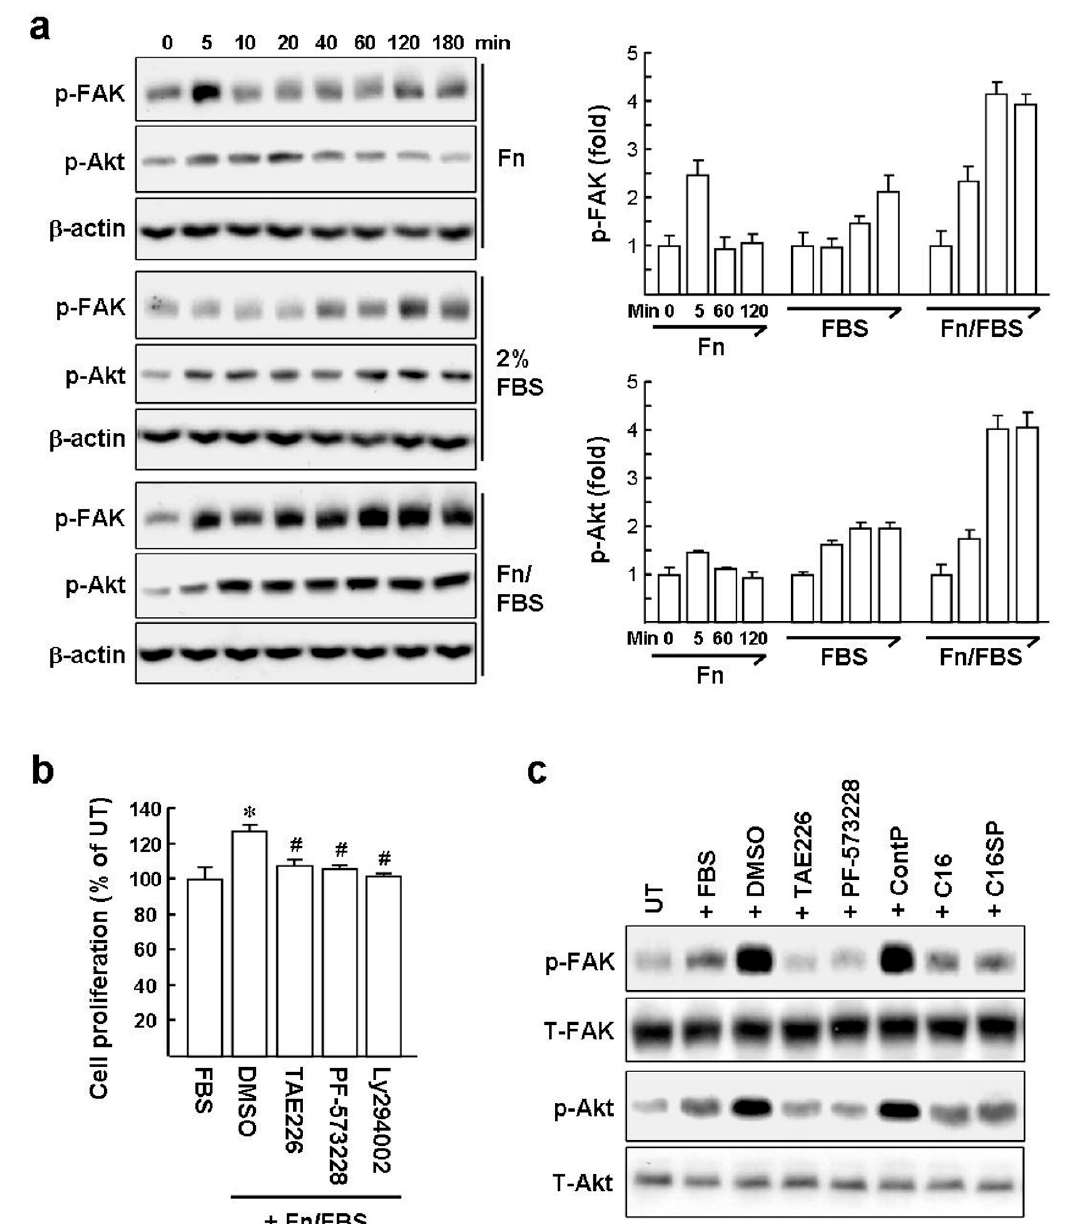
Figure 2. C16 and C16SP suppress Fn and serum-induced HaCat cell proliferation by blocking the FAK / PI3K / Akt signaling. ( a ) Fn and FBS synergistically induce phosphorylation of FAK at Y397 and Akt at T308 in HaCat cells in a time-dependent fashion. Cells were serum starved for 24 h and then treated with fresh medium containing 5 µ g / mL of Fn or 2% FBS or both (Fn / FBS), for the time periods indicated. Representative immunoblots and densitometric analysis are from three independent experiments. β -actin served as a protein loading control. ( b ) E ff ect of the FAK inhibitors (NVP-TAE226 and PF-573228) and PI3K inhibitor (LY294002) on HaCat cell proliferation. Cells were serum starved for 24 h and then exposed to fresh medium containing 5 µ M FAK or PI3K inhibitor for 30 min before addition of Fn / FBS for another 24 h. Cells treated with 2% FBS alone served as proliferative index 100%. Data represent three independent experiments, each performed in quadruplicate. * p < 0.005 versus FBS-treated cells. # p < 0.002 versus DMSO solvent-treated cells. ( c ) C16 and C16SP suppress Fn / FBS-induced phosphorylation of FAK and Akt. Serum-starved HaCat cells were treated with FAK inhibitor for 30 min or 10 µ M C16 peptide for 60 min before Fn / FBS stimulation for 1 h. One representative immunoblot from three independent experiments is shown.